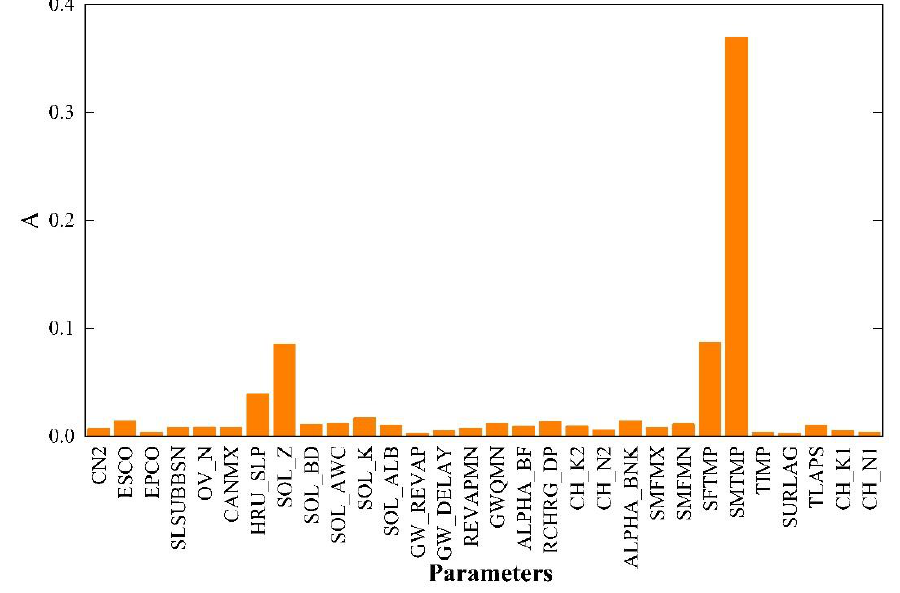
Figure 9. Schematic diagram of parameter sampling of FAST sampling method, taking CN2 as an example.